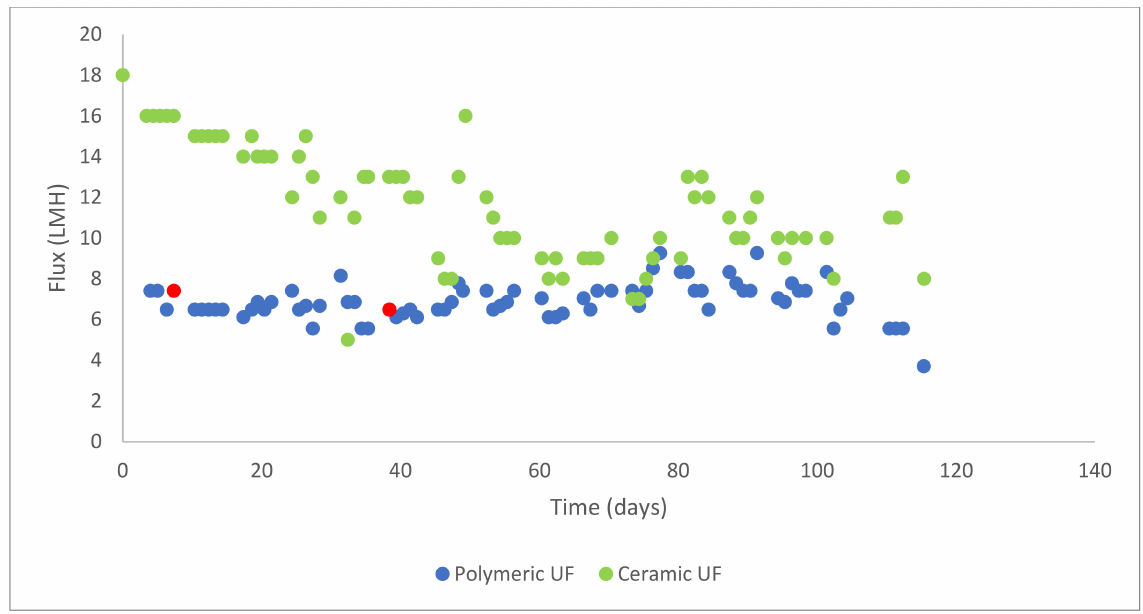
Figure 3. Flux of the Polymeric UF and the Ceramic UF. The red dots indicate the membrane changeovers on the polymeric UF